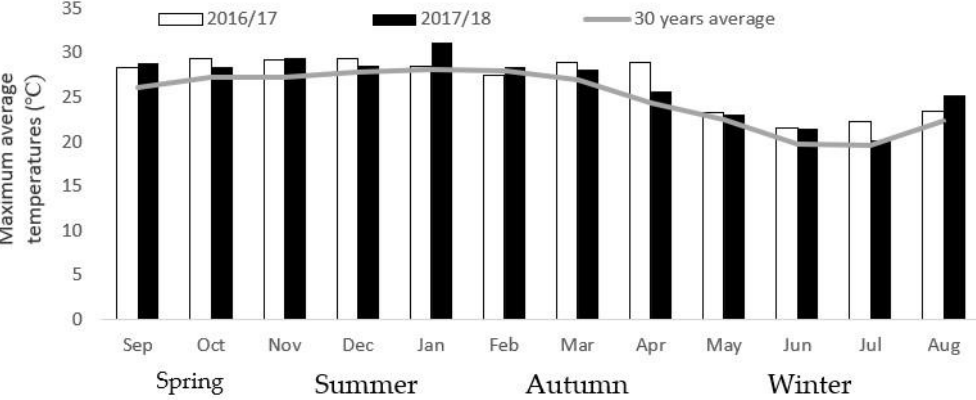
Figure 2. Long-term average and experimental year monthly average temperatures (°C) for University of Pretoria Experimental Farm. Table 1. Table showing soil pH, sand%, clay% and silt% at different rainfall reduction and resting periods.